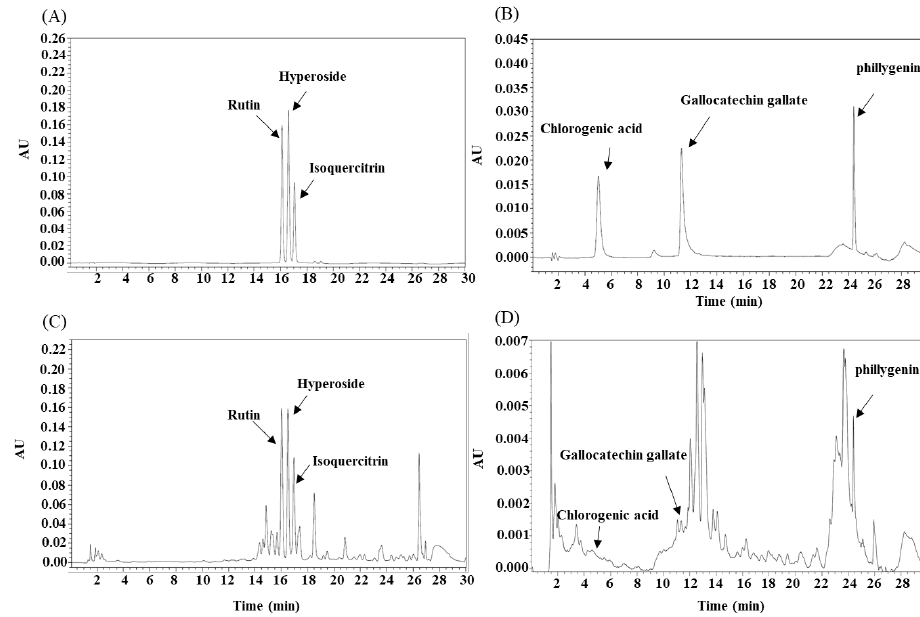
Figure 1. Analysis of Camellia japonica extracts by High Performance Liquid Chromatography (HPLC) ( A , B ): standard; ( C , D ): sample.